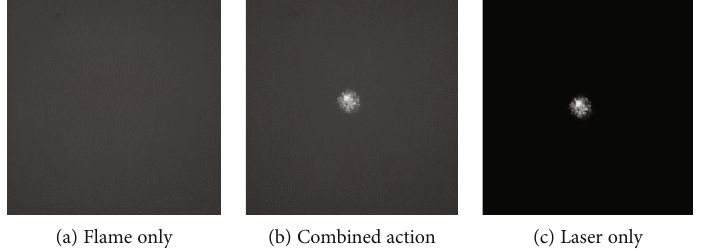
Figure 14: The re fl ected intensity distributions from the di ff used white screen.